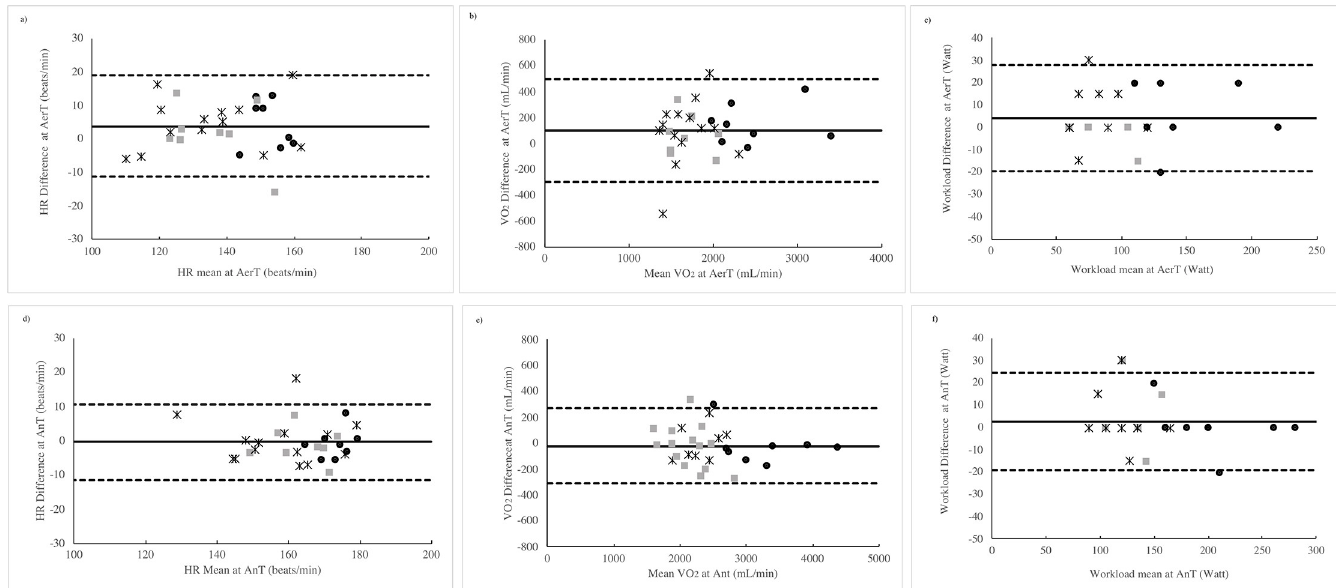
Fig 3. Bland-Altman plots of HR, VO2 and workload (first, second and third line, respectively) estimated by RQA and GE methods at AerT (left) and AnT (right). Group A (black circle), group B (grey square) and group C (black star).